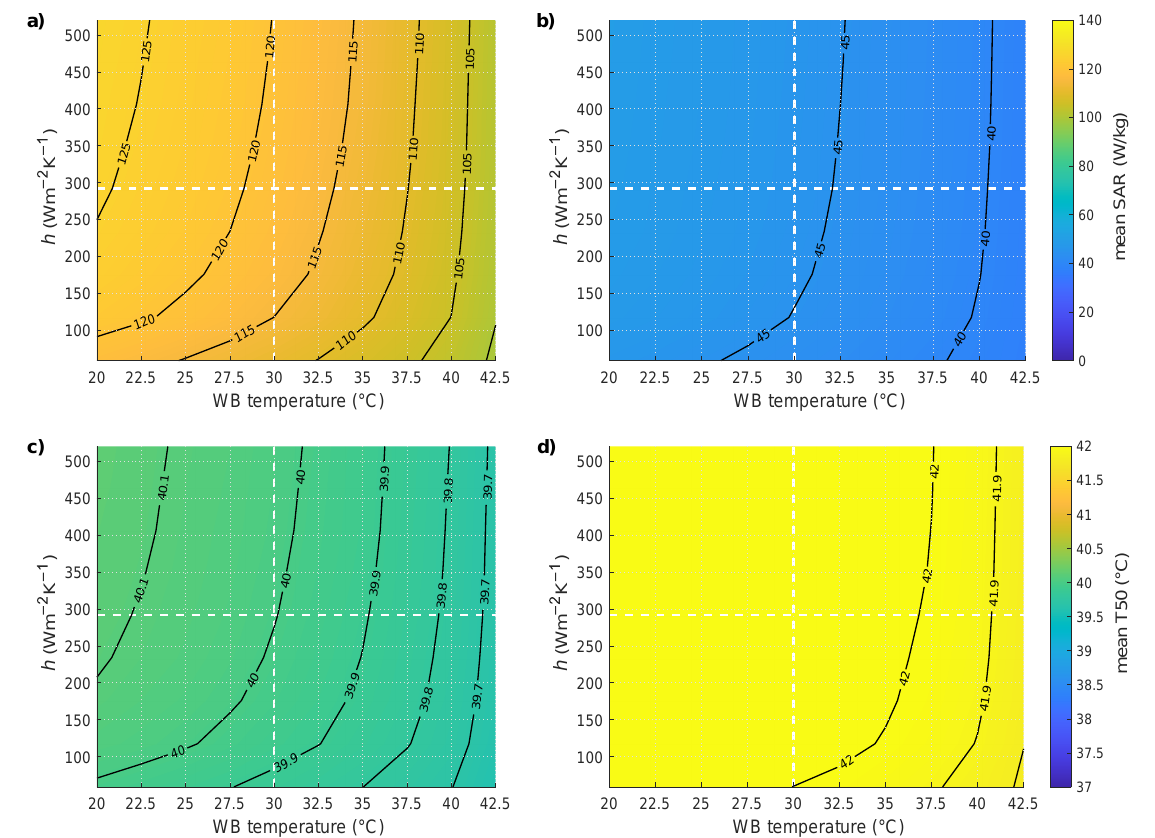
Figure 8. Mean SAR and mean T50 from 59 treatments with median CTV depth more than 20 mm as a function of water bolus (WB) temperature and water bolus heat transfer coefficient (h) for ( a , c ) constant model and ( b , d ) temperature-dependent blood perfusion model.